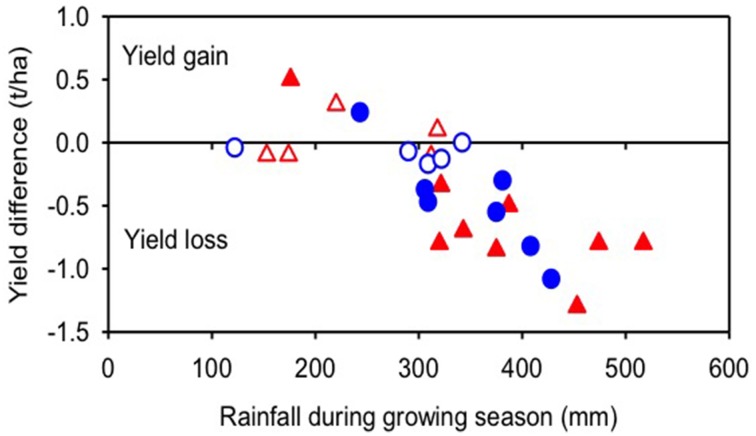
The yield response to Conservation Agriculture also varies with seasonal conditions at individual sites. At two long-term experiments in south-eastern Australia [Harden  (Kirkegaard et al., 1994) and Wagga Wagga  (Heenan et al., 1994)], the yield of wheat under a stubble-retain, no till (CA) treatment suffers a yield penalty compared to minimum-tillage-late burn treatment in wetter seasons (>300 mm), shows little difference in dry seasons (<250 mm) with only two instances of significantly higher yield. Open symbols are shown where treatments were not significantly different (P < 0.05).